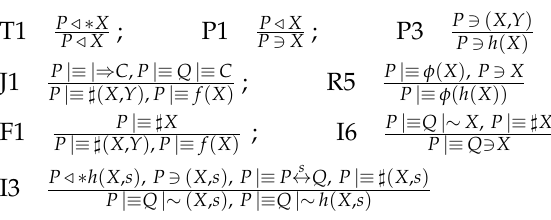
Figure A3. GNY logic